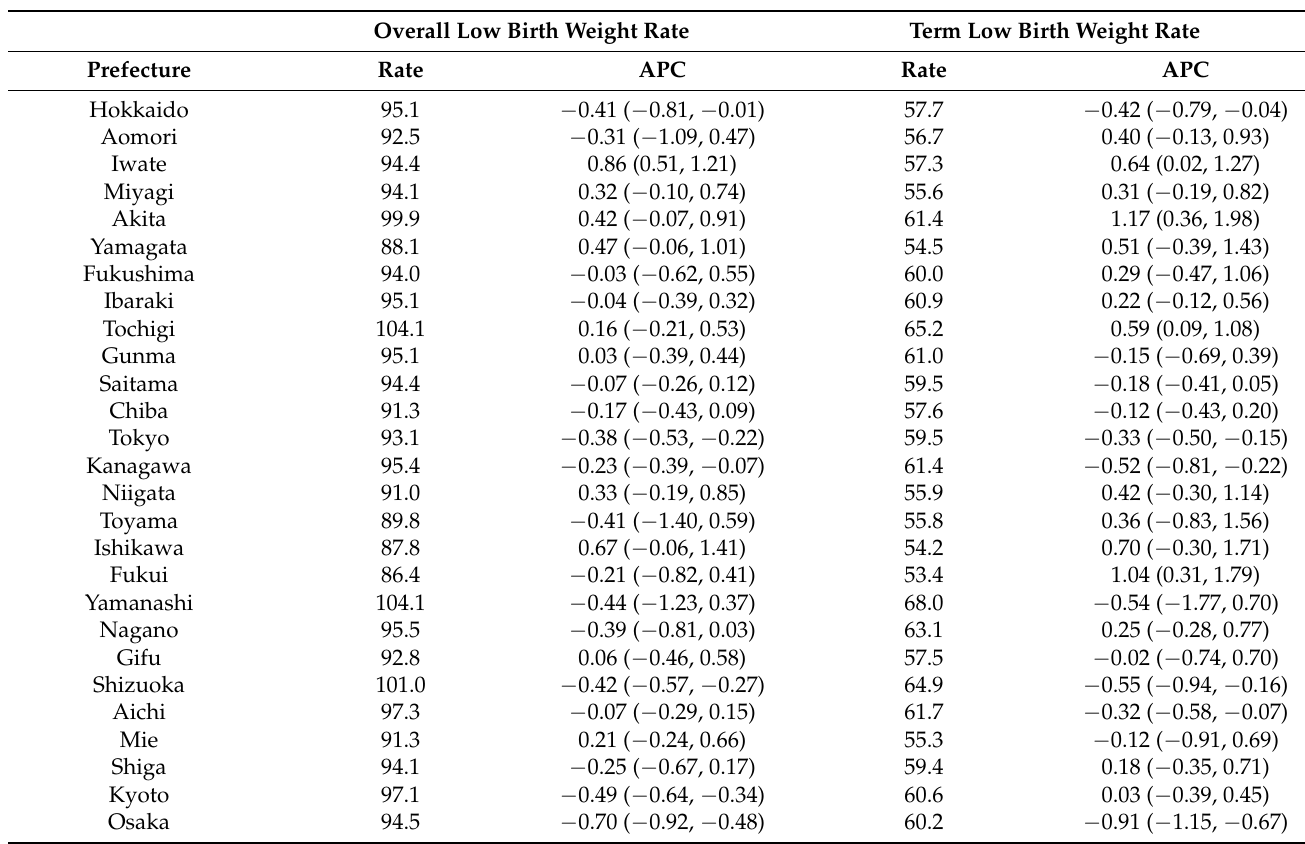
Table 4. The overall low birth weight rate and the term low birth weight rate per 1000 births in 2007–2019 for each prefecture and their